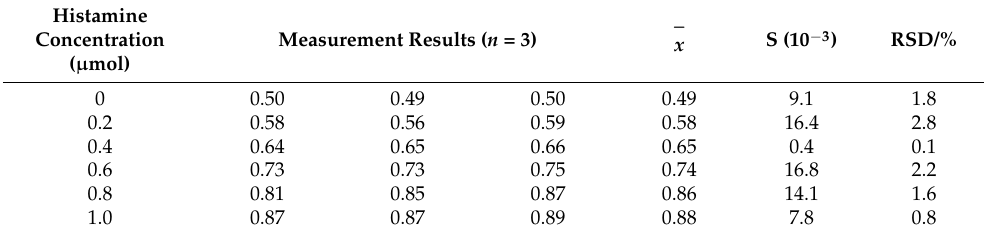
Table 2. Precision analysis of the absorbance value (A) determination